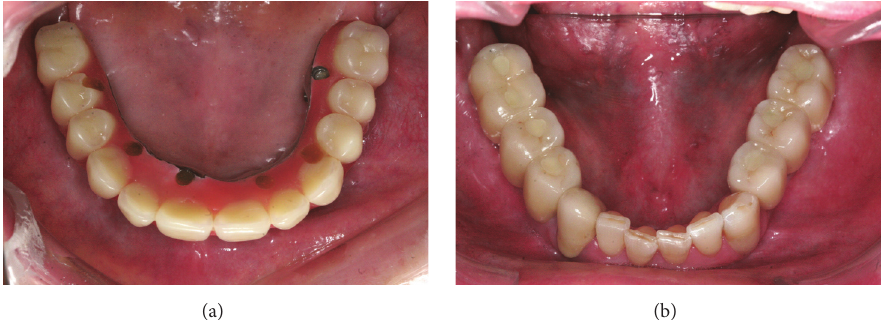
Figure 8: Occlusal view of final restoration: (a) maxilla and (b) mandible.